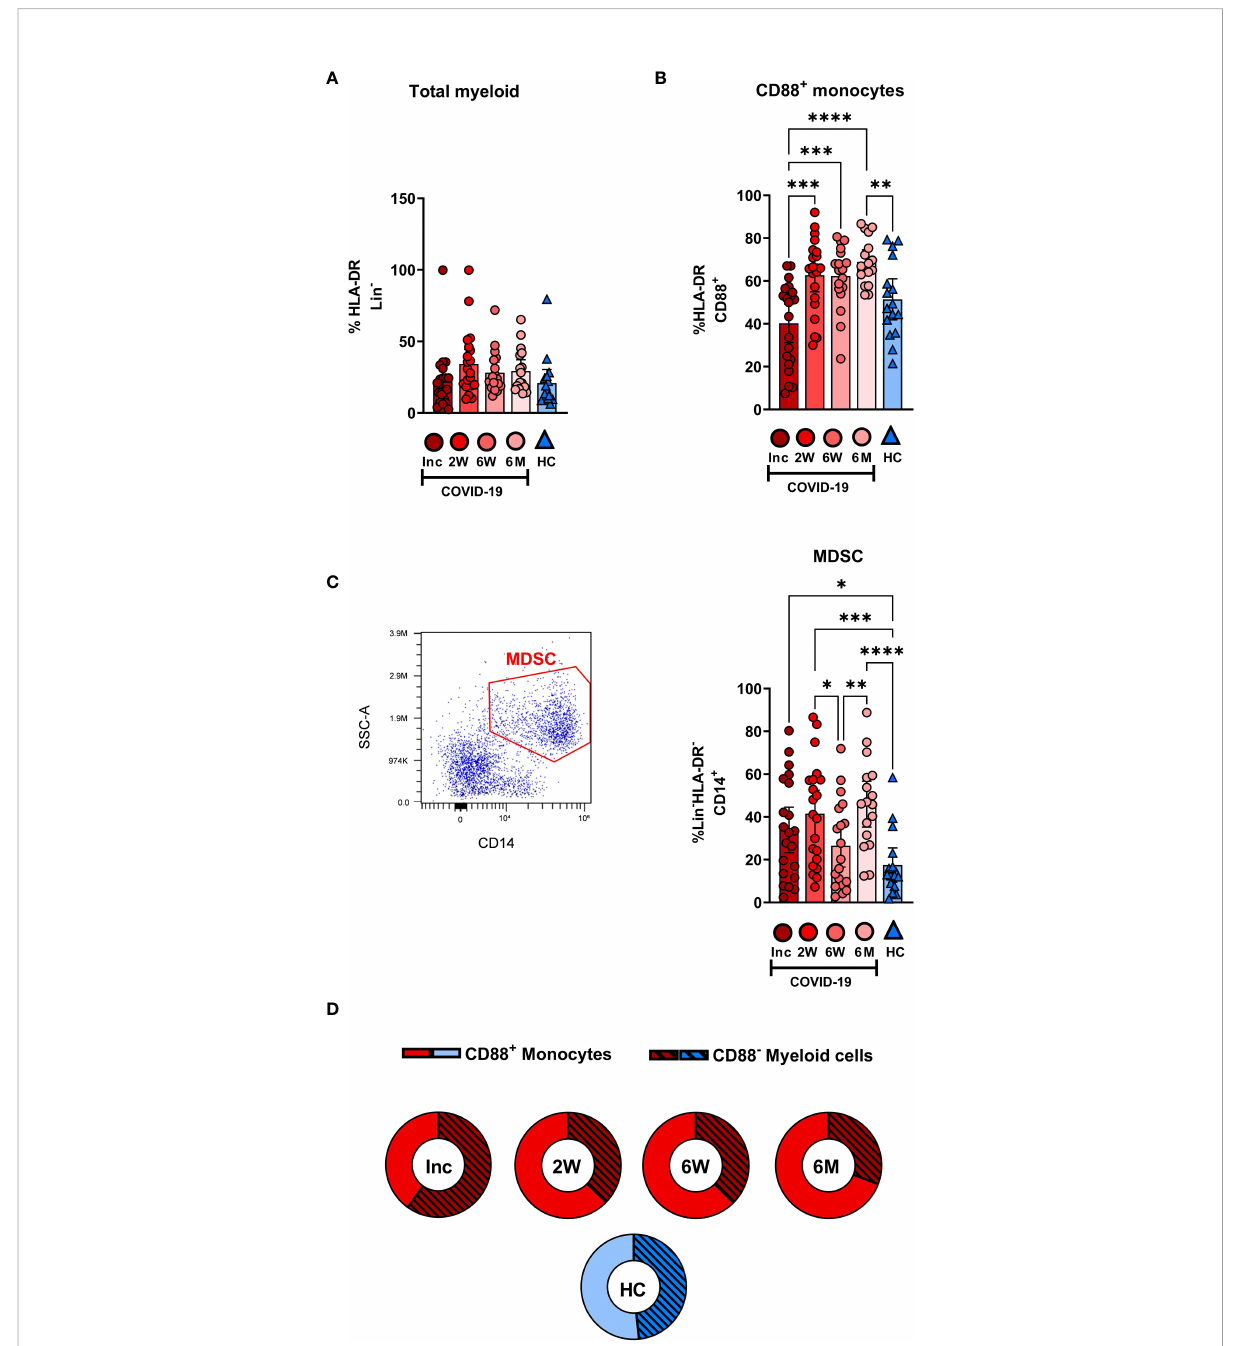
FIGURE 2 Dysregulation in the frequency of myeloid compartments persists for 6 months in hospitalized COVID-19 patients. PBMCs obtained from 21 COVID-19 patients and 16 healthy donors over a 6-7 month period were stained with monoclonal antibodies and assessed by fl ow cytometry to identify the myeloid cell subsets. Percentage of the cells comprising (A) the total HLA-DR + Lin - myeloid compartment and (B) CD88 + monocytes. (C) Representative gating and percentage of CD14 + HLA - DR-Lin - MDSC. (D) Ratio of CD88 + monocytes to CD88 - myeloid cells. Data is represented as mean with 95% Cl, with signi fi cance of *p ≤ 0.05, **p ≤ 0.01, ***p ≤ 0.001, ****p ≤ 0.0001, determined using Brown- Forsythe and Welch ANOVA tests. Inc, Study inclusion; 2W, 2 weeks; 6W, 6 weeks; 6M, 6-7 months; HC, healthy